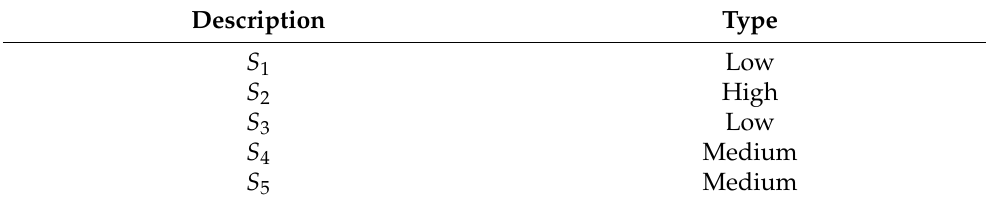
Table 8. Service